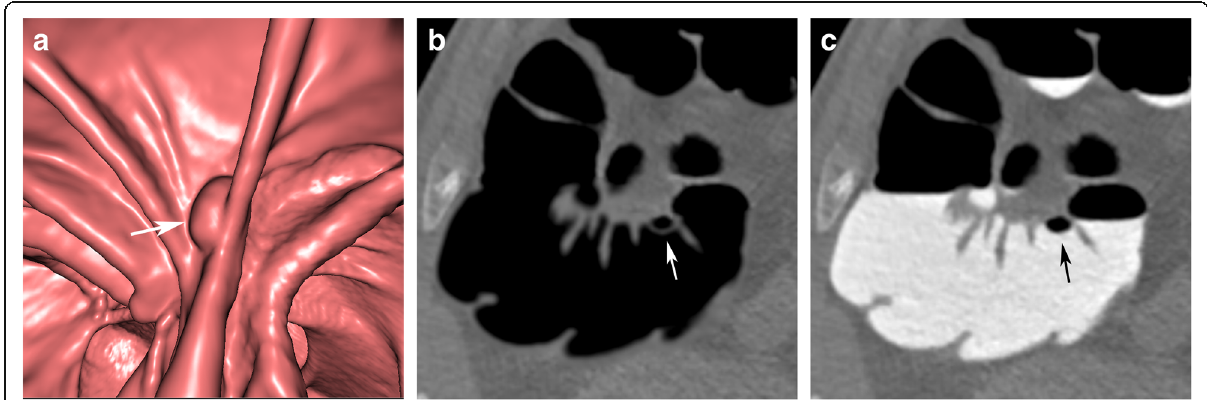
Fig. 7 Pseudopolyp at the right colonic flexure due to trapped gas bubbles after EC. a In an endoluminal 3D view after EC, an oval filling defect is visible, simulating a sessile polyp (arrow). b In the corresponding 2D image after EC, a gas-filled cyst with a thin wall is seen (arrow). c In the unsubtracted 2D image, the round lesion correlates with a gas bubble trapped between two semilunar folds (arrow)